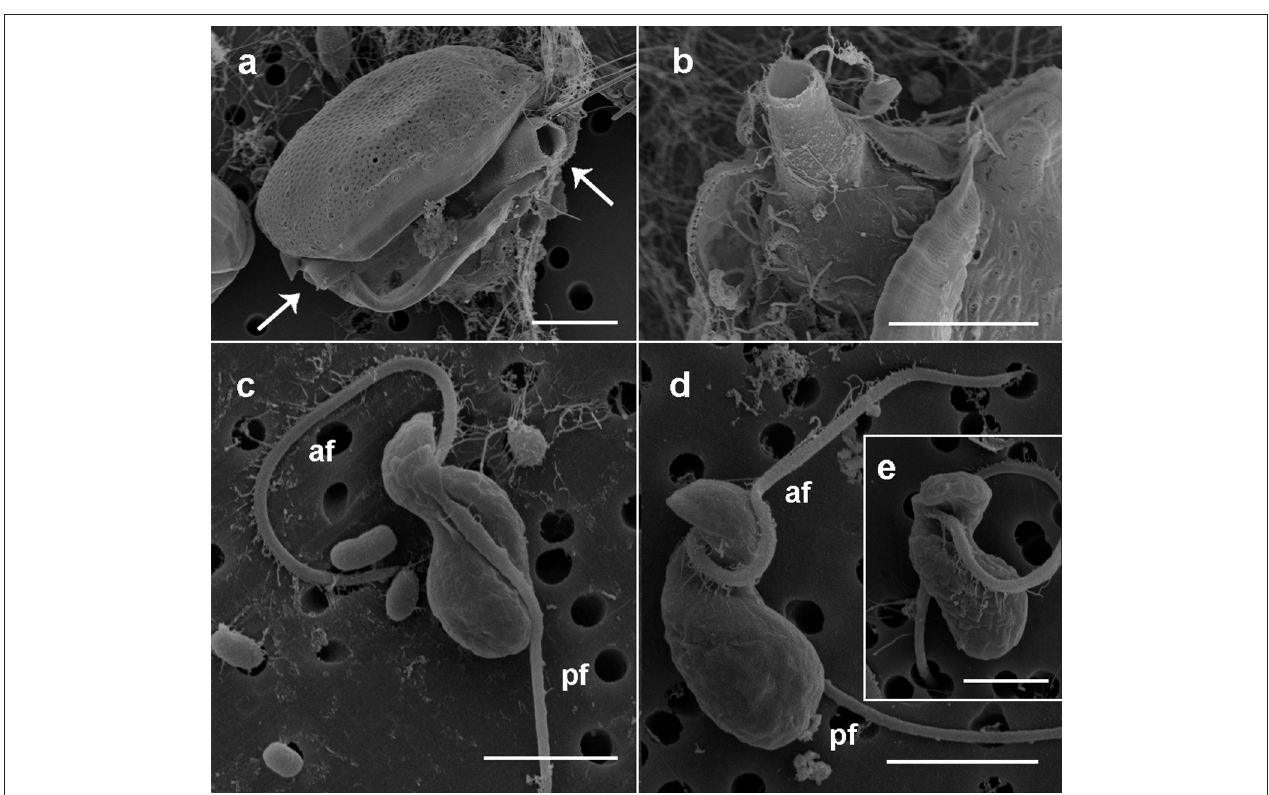
FIGURE 2 | Scanning electron microscopy micrographs of the sporangia and zoospores of Dinovorax pyriformis . (a) Prorocentrum micans cell broken because of the emergence through the sagittal suture of two open germ-tubes (arrows) of D. pyriformis . (b) Detail of the sporangium inside the host theca and the opened germ-tube emerging out of it. (c) Right lateral view of a zoospore. The naked posterior flagellum lies in a cavity running all along the lateral side of the cell. (d) Left lateral view of a zoospore. The hairy anterior flagellum encircles the cell to its left side. (e) Ventral view of a zoospore showing the insertion point of the anterior flagellum. Scale bars: (a,b) = 10 µ m, (c,d) = 3 µ m, (e) = 1 µ m. af, Anterior flagellum; pf, posterior